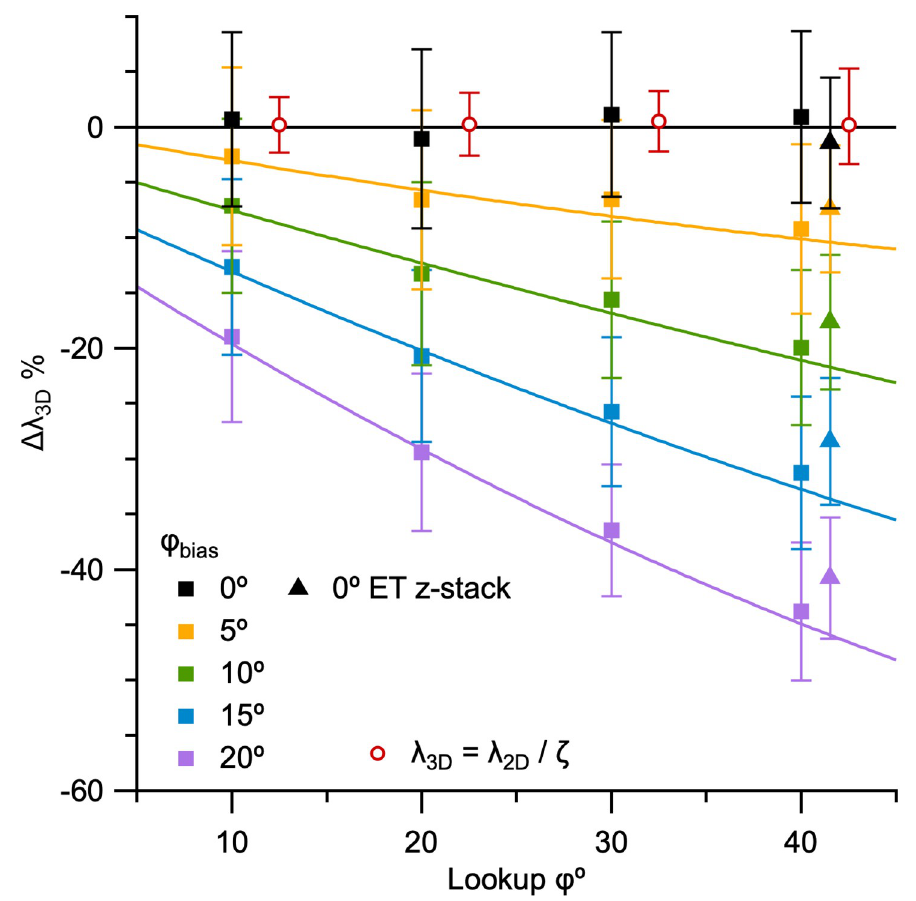
Fig 12. Estimation errors of the 3D density computed via the disector method for different degrees of bias due to blind-versus-nonblind cap detection. Average Δλ 3D computed from Monte Carlo simulations of the disector method, where a particle-detection bias was simulated by increasing ϕ of the reference section (a blind cap detection) with respect to the lookup section (a nonblind cap detection) for ϕ bias = 0–20˚ (colored squares; ϕ ref = ϕ lookup + ϕ bias ; ~500 particles per reference section). Thickness of the reference and lookup sections was 0.3 u.d. An equivalent disector analysis using the ET11 z-stack data gave similar results (triangles; lookup ϕ = 42˚). Average Δλ 3D for the simulations in Fig 10B are shown for comparison (red open circles; T = 0 u.d.; λ 3D = λ 2D / z ; x-scale is true ϕ and is shifted 2.5˚ to avoid overlap) highlighting the higher levels of accuracy compared to the disector method, i.e. smaller confidence intervals ( σ Δ